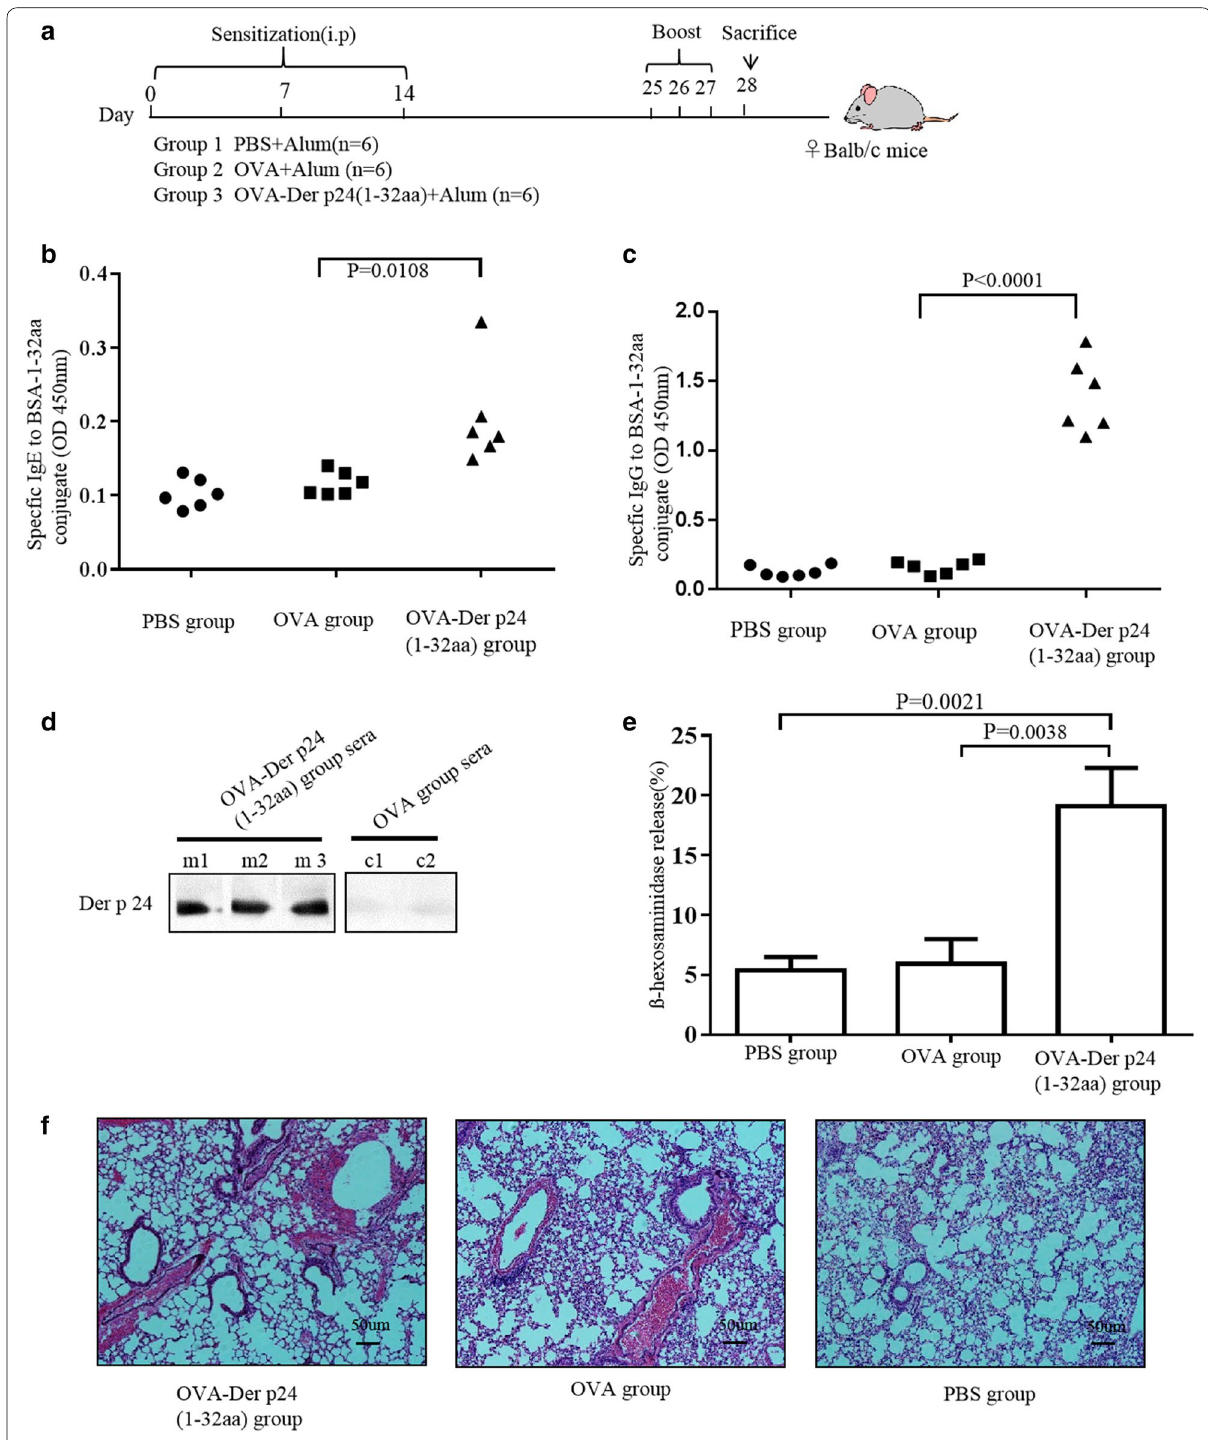
Fig. 4 Induction of IgE production by N‑terminal 32‑residue region of Der p 24 in Balb/c mice. a Experimental design. Postmmunization indirect ELISA detection of specific IgG ( b ) and IgE ( c ) antibodies against the conjugate. d IgE‑western blot of rDer p 24 with sera from the OVA‑Der p 24(1– 32aa) (m1–m3 represent three different individuals) and OVA (c1 and c2 represent two different individuals) groups. e Significantly greater RBL‑2H3 cell ß‑hexosaminidase release was induced by sera from the OVA‑Der p24(1–32aa) group than that induced by sera from the OVA and PBS groups. f Light photomicrographs of H&E‑stained sections of lung tissues in mice challenged with OVA‑Der p24(1–32aa), OVA, or PBS ( values < 0.05 were considered